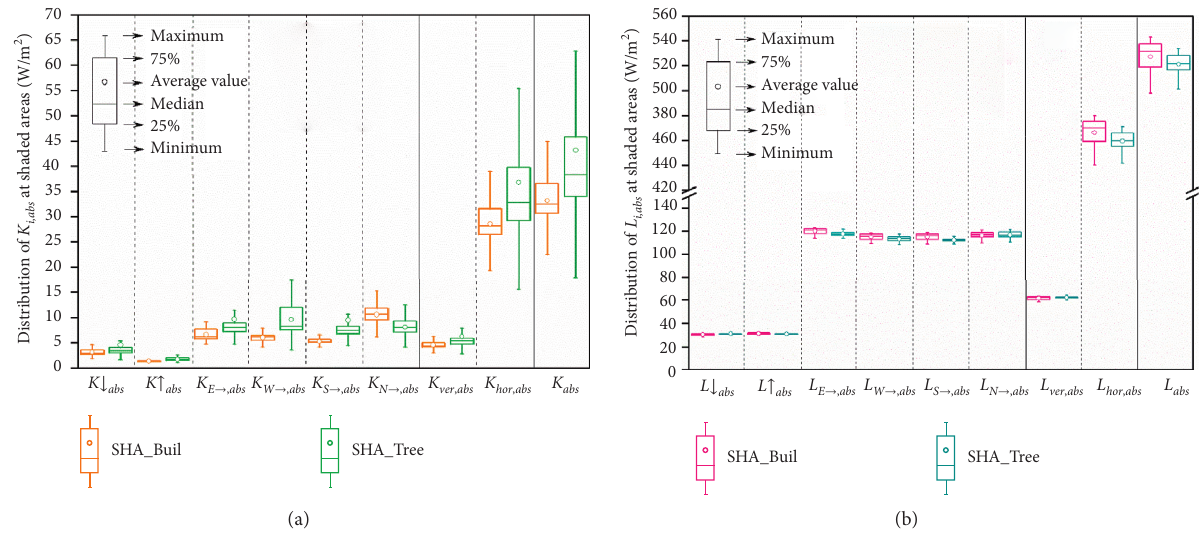
Figure 8: Short- and long-wave radiant flux densities absorbed by the reference standing person: (a) K